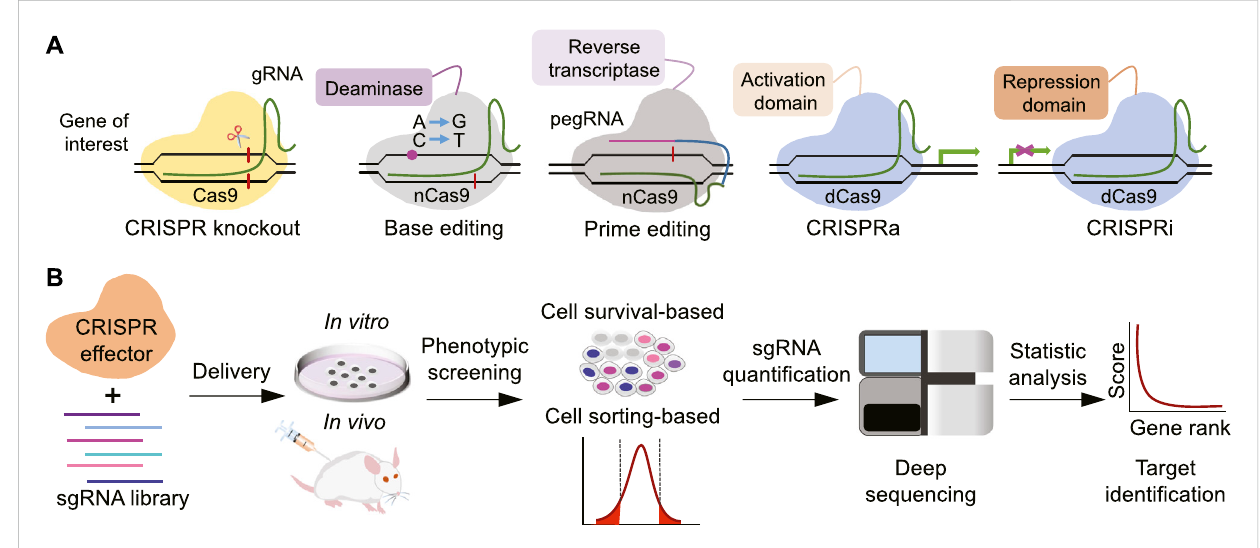
FIGURE 1 Overview of CRISPR technology. (A) Major modules of CRISPR toolbox. (B) Work fl ow of typical CRISPR screening